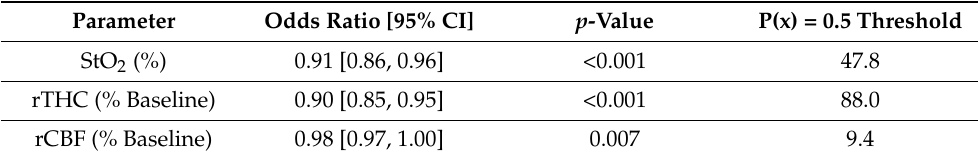
Table 3. Odds Ratios and Thresholds for Cerebral Hemodynamic Prediction of Glycerol >100 µ